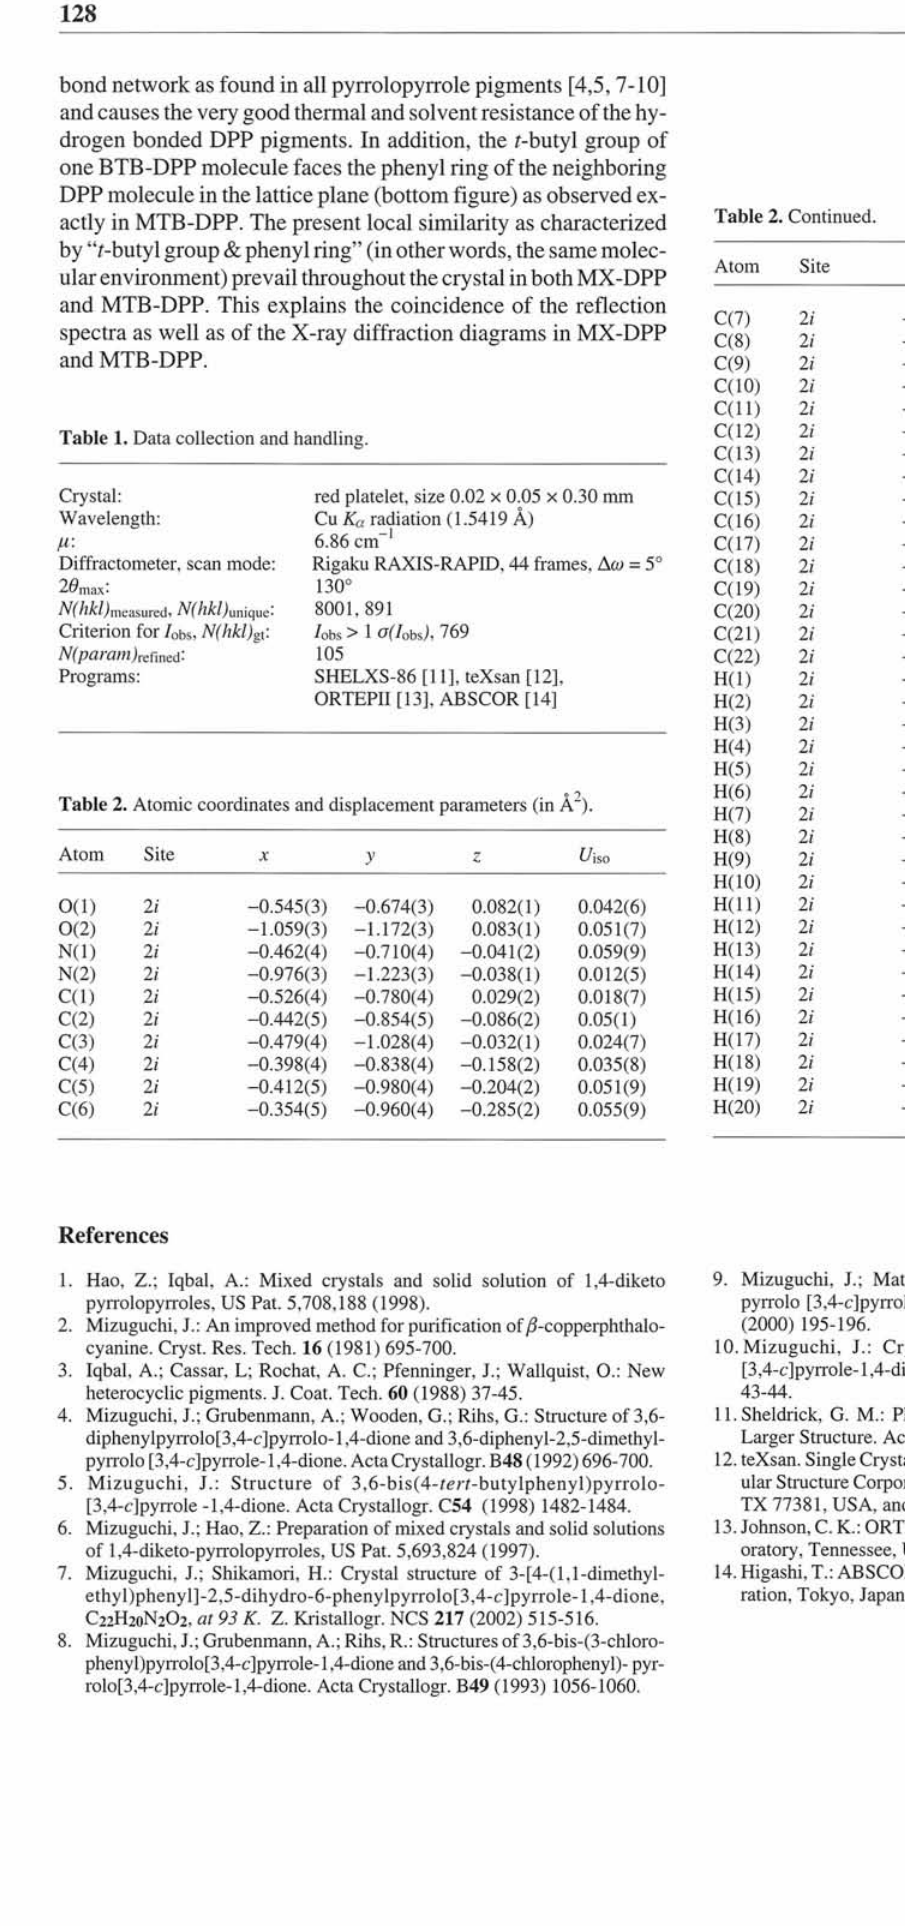
Table 1. Data collection and handling.